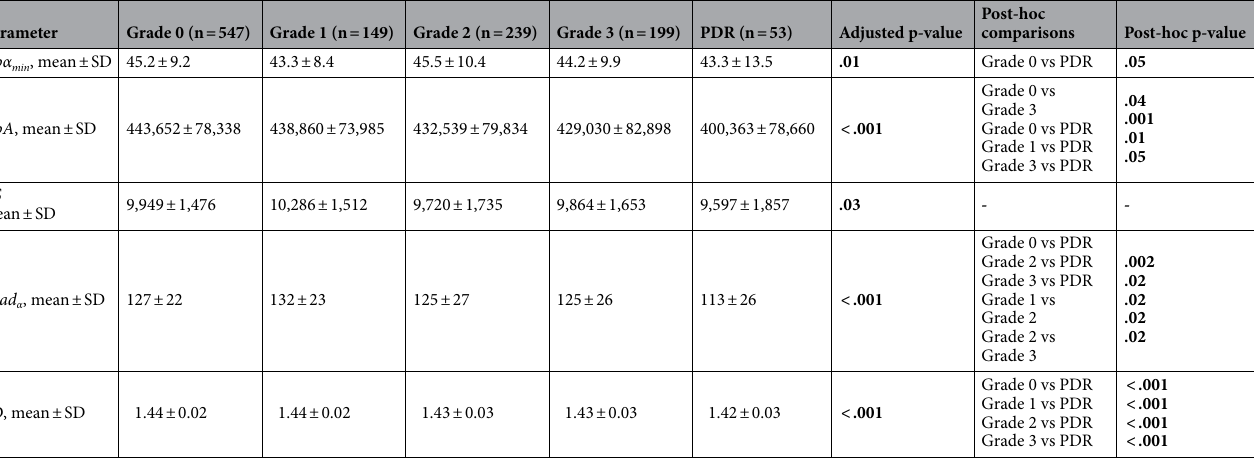
Table 1. Means and standard deviations of α-shape descriptors and FD parameter. P-values based on non- parametric ANOVA (K-Wallis) with correction for multiple comparisons (Benjamani-Hochberg). PDR proliferative diabetic retinopathy, n number of